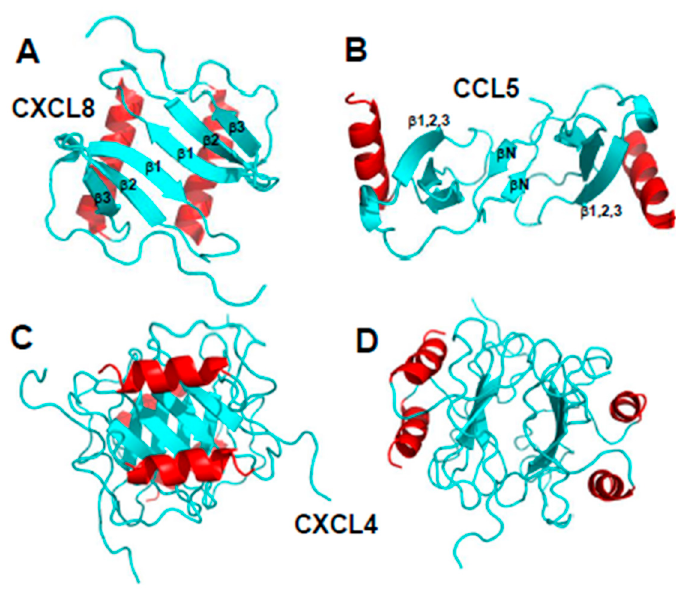
Figure 2. Structures of CXC chemokine CXCL8 (Interleukin-8, PDB access code 1IL8, [10]) (panel A ) and CC chemokine CCL5 (RANTES, PDB access code 5COY, [17]) (panel B ) are shown. Two orientations of the CXCL4 M2 tetramer structure (platelet factor-4, PF4; PDB access code 1PFM, [18]) are shown in panels ( C,D ). C-terminal helices are colored red, and the remaining sequences are colored cyan.